Question: Write a single sentence explaining what this figure depicts.
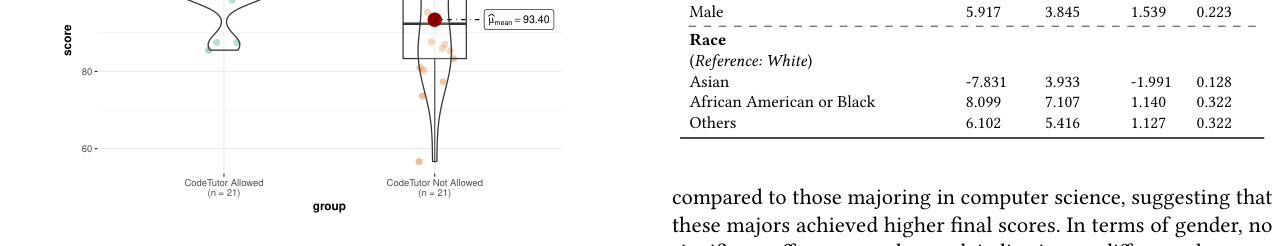
Answer: Parametric pairwise comparison (ANOVA) reveals a significantly higher mean score in the “CodeTutor-Allowed” group compared to the “CodeTutor-Not-Allowed” group.